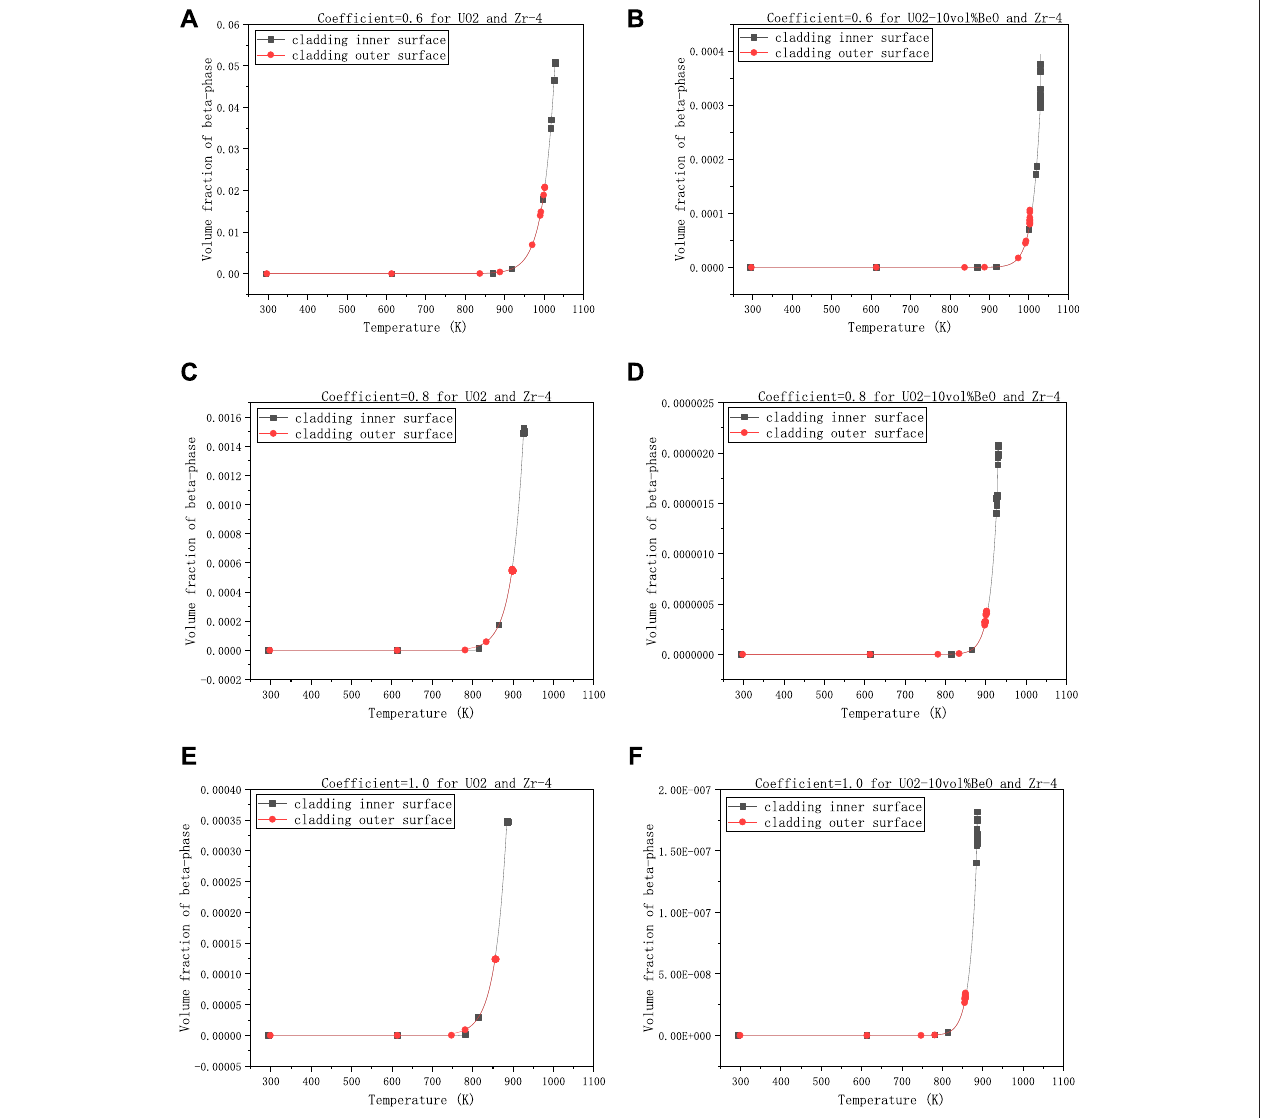
FIGURE6| Volumefractionsof β -phaseoncladdinginnersurfaceandouter-surface,changingwiththeheattransfercoef fi cientmultipliedbyanumbersmallerthan 1, (A) 0.6forUO 2 andZircaloy-4, (B) 0.6forUO 2 -10vol%BeOandZircaloy-4, (C) 0.8forUO 2 andZircaloy-4, (D) 0.8forUO 2 -10vol%BeOandZircaloy-4, (E) 1.0forUO 2 and Zircaloy-4, (F) 1.0 for UO 2 -10vol%BeO and Zircaloy-4.